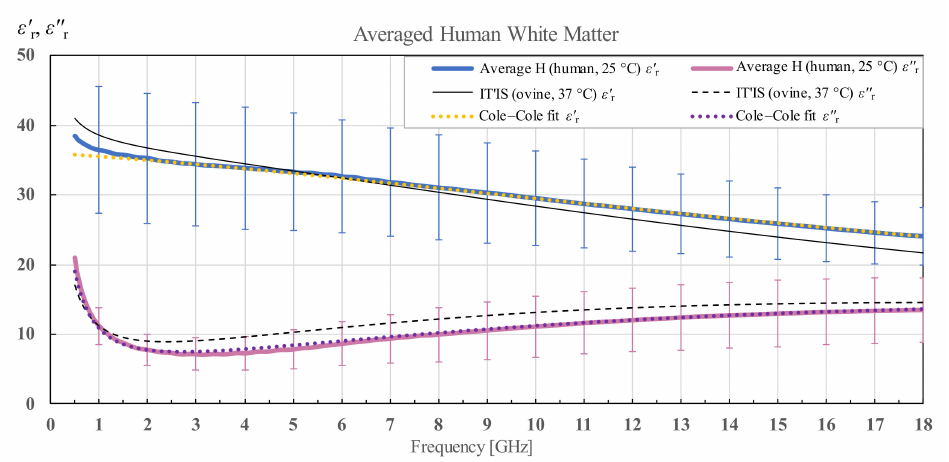
Figure 4. Average permittivity of human white matter with standard deviation and Cole–Cole fit, shown in comparison with the data from IT’IS database [21].